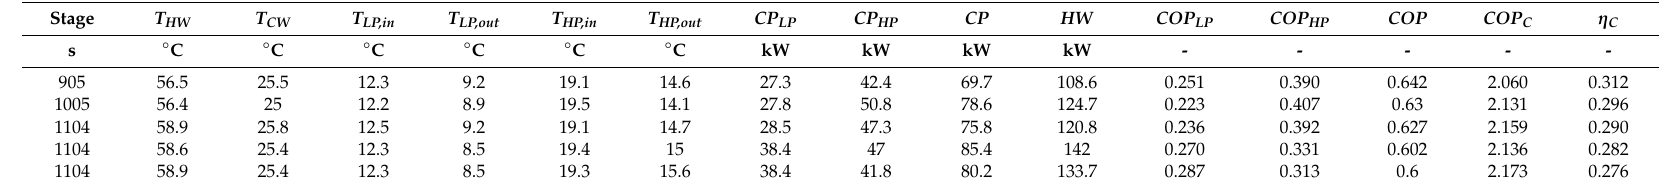
Table 4. Results of five measurements with the highest COP value (original control system).